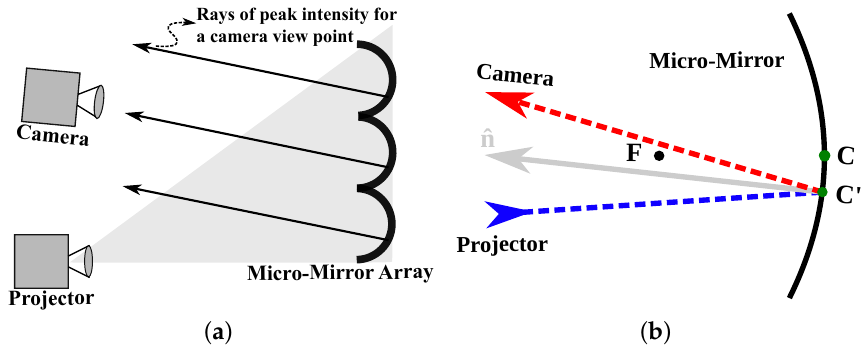
Figure 2. ( a ) schematic of the calibration configuration; ( b ) difference between the observed point C (cid:48) and the actual center C of the mirror. The position of the observed point is dependent on the focal length of the mirror and the direction of the projected ray, as well as the surface normal ˆ n